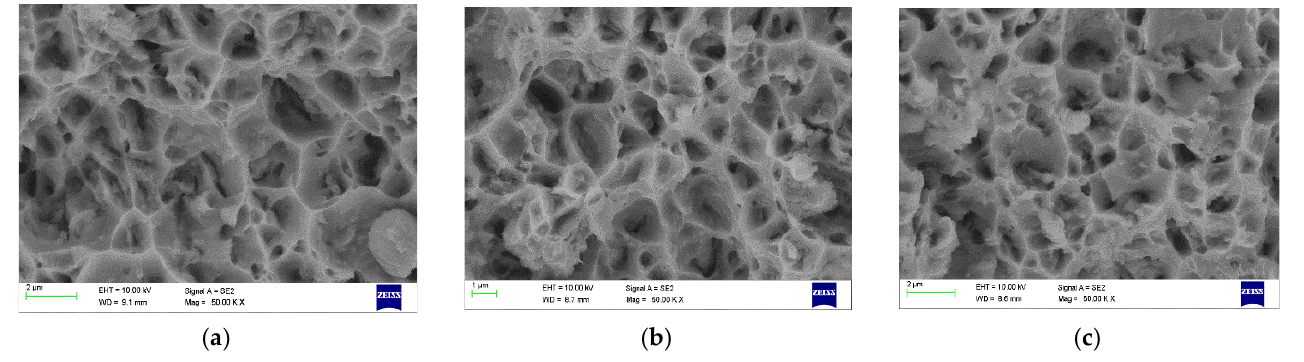
Figure 23. Fractography SEM image of 6061 ( a ) 1% Gr ( b ) 2%Gr ( c ) 3%Gr.